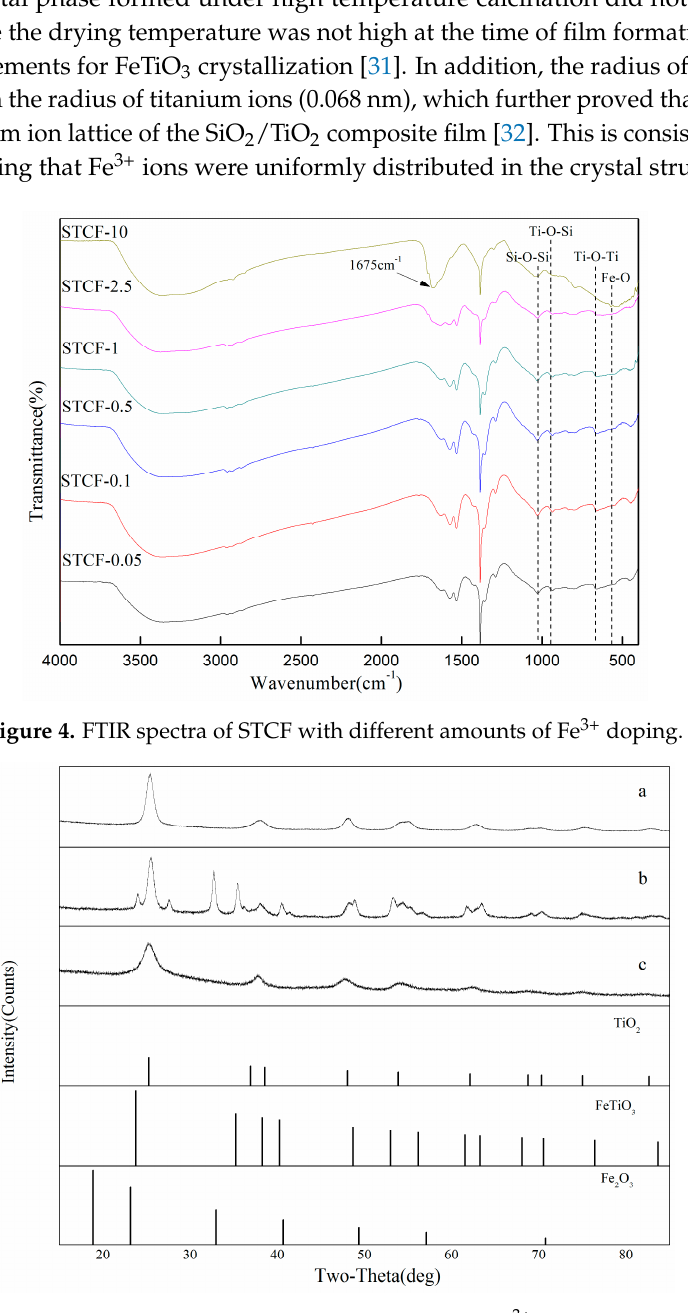
Figure 5. XRD patterns of STCF with different doping amounts of Fe 3+ ions as well as under different treatment temperatures: ( a ) STCF-1 under 800 °C calcination, ( b ) STCF-10 under 800 °C calcination, and ( c ) STCF-10 dried at 103 °C.